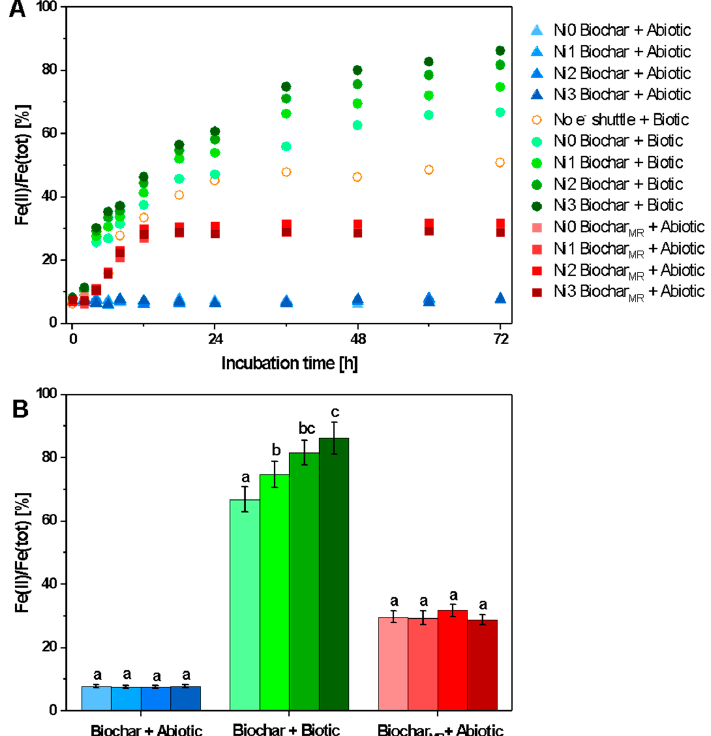
Figure 1. Reduction of ferrihydrite by S. oneidensis MR-1. ( A ) Formation curves of Fe(II) in bottles amended with different Ni-level biochars. ( B ) Fe(II) formation in bottles amended with different Ni-level biochars within 72 h. “Biotic” and “abiotic” indicate setups with and without MR-1 cells added, respectively. “Biochar MR ” indicates biochar after 72 h of microbial reduction by S. oneidensis MR-1. Ni0, Ni1, Ni2, and Ni3 indicate 0.09 g kg − 1 , 494 g kg − 1 , 1156 g kg − 1 and 1641 g kg − 1 , respectively, of Ni in biochars (See Table 1). In (B), means followed by the same lowercase letter for each setup are not significantly different at p < 0.05 ( t -test). Table 1. Physicochemical properties of biochars with different Ni contents. Mean (±SE, n = 3).